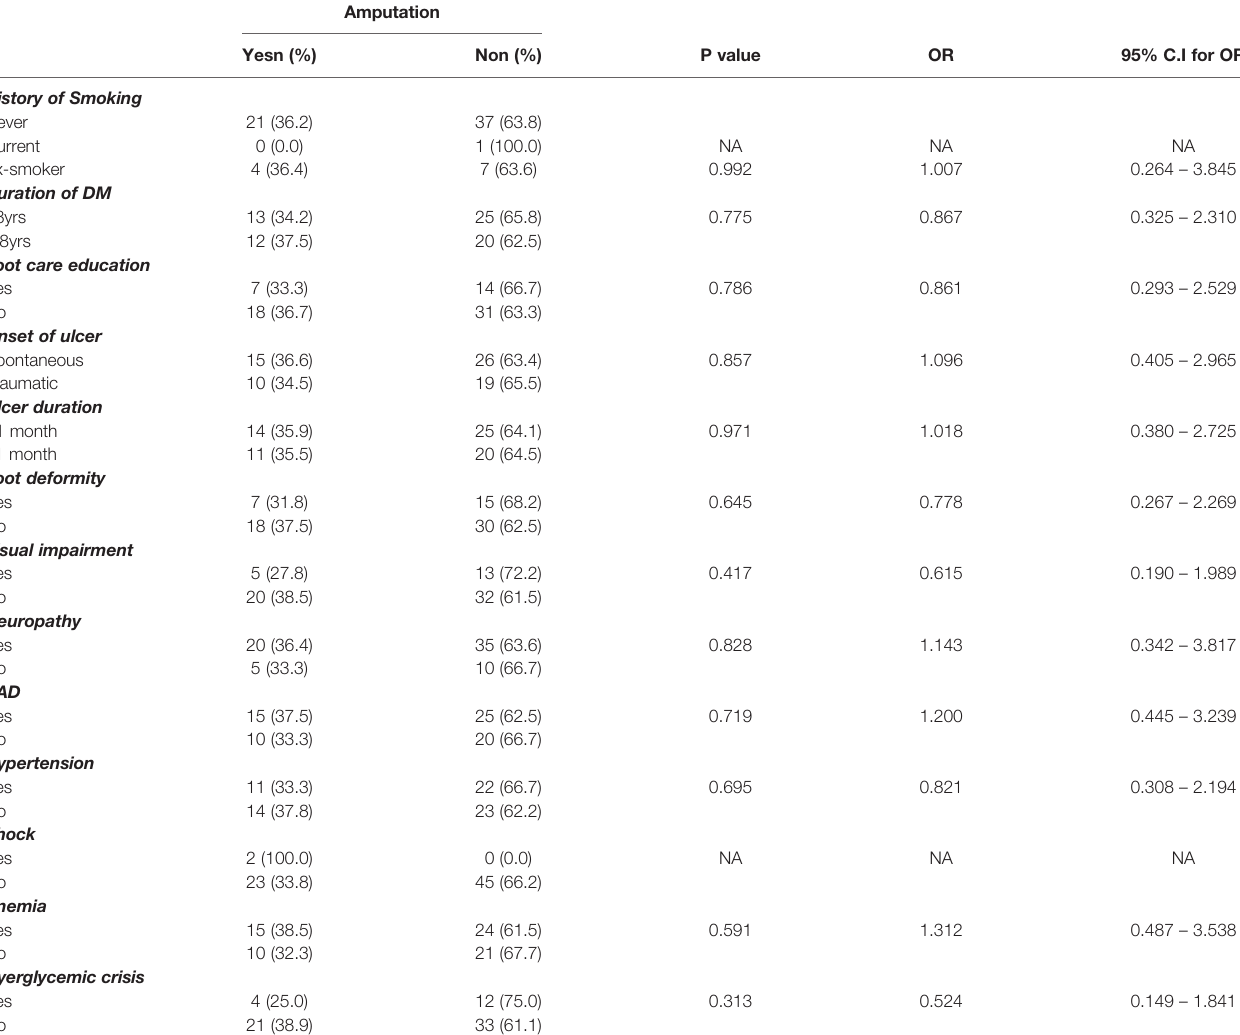
TABLE 2 | Relationship between clinical and demographic variables and